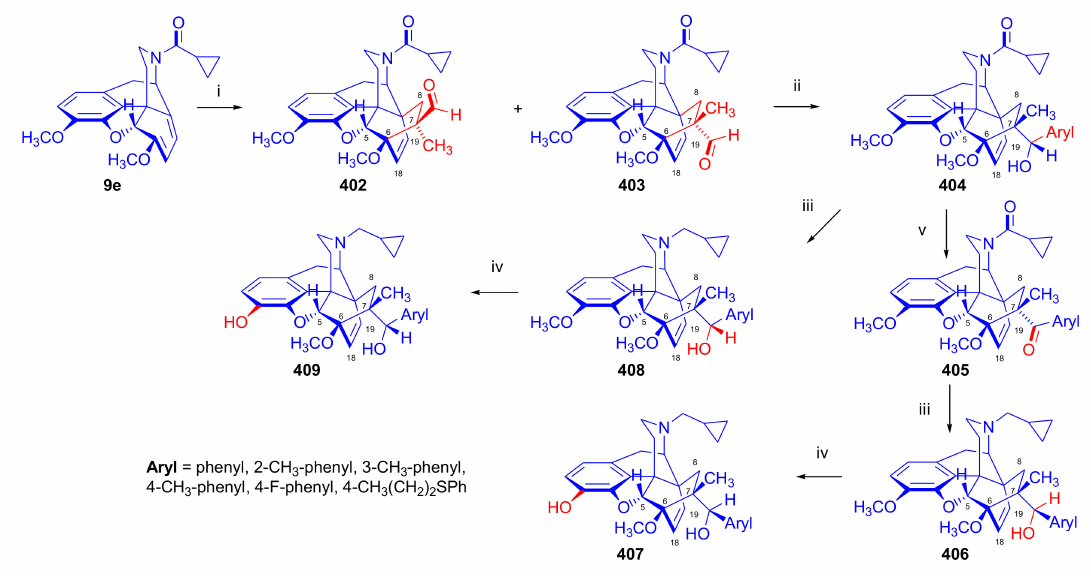
Figure 103. Synthesis of 7 β -methyl orvinol analogues. Reagents and conditions : (i): metacrolein, LiBF 4 , room temperature, 16 h; (ii): two equiv. ArMgBr, three equiv. Bu 4 NBr, THF, reflux, 48 h; (iii): LiAlH 4